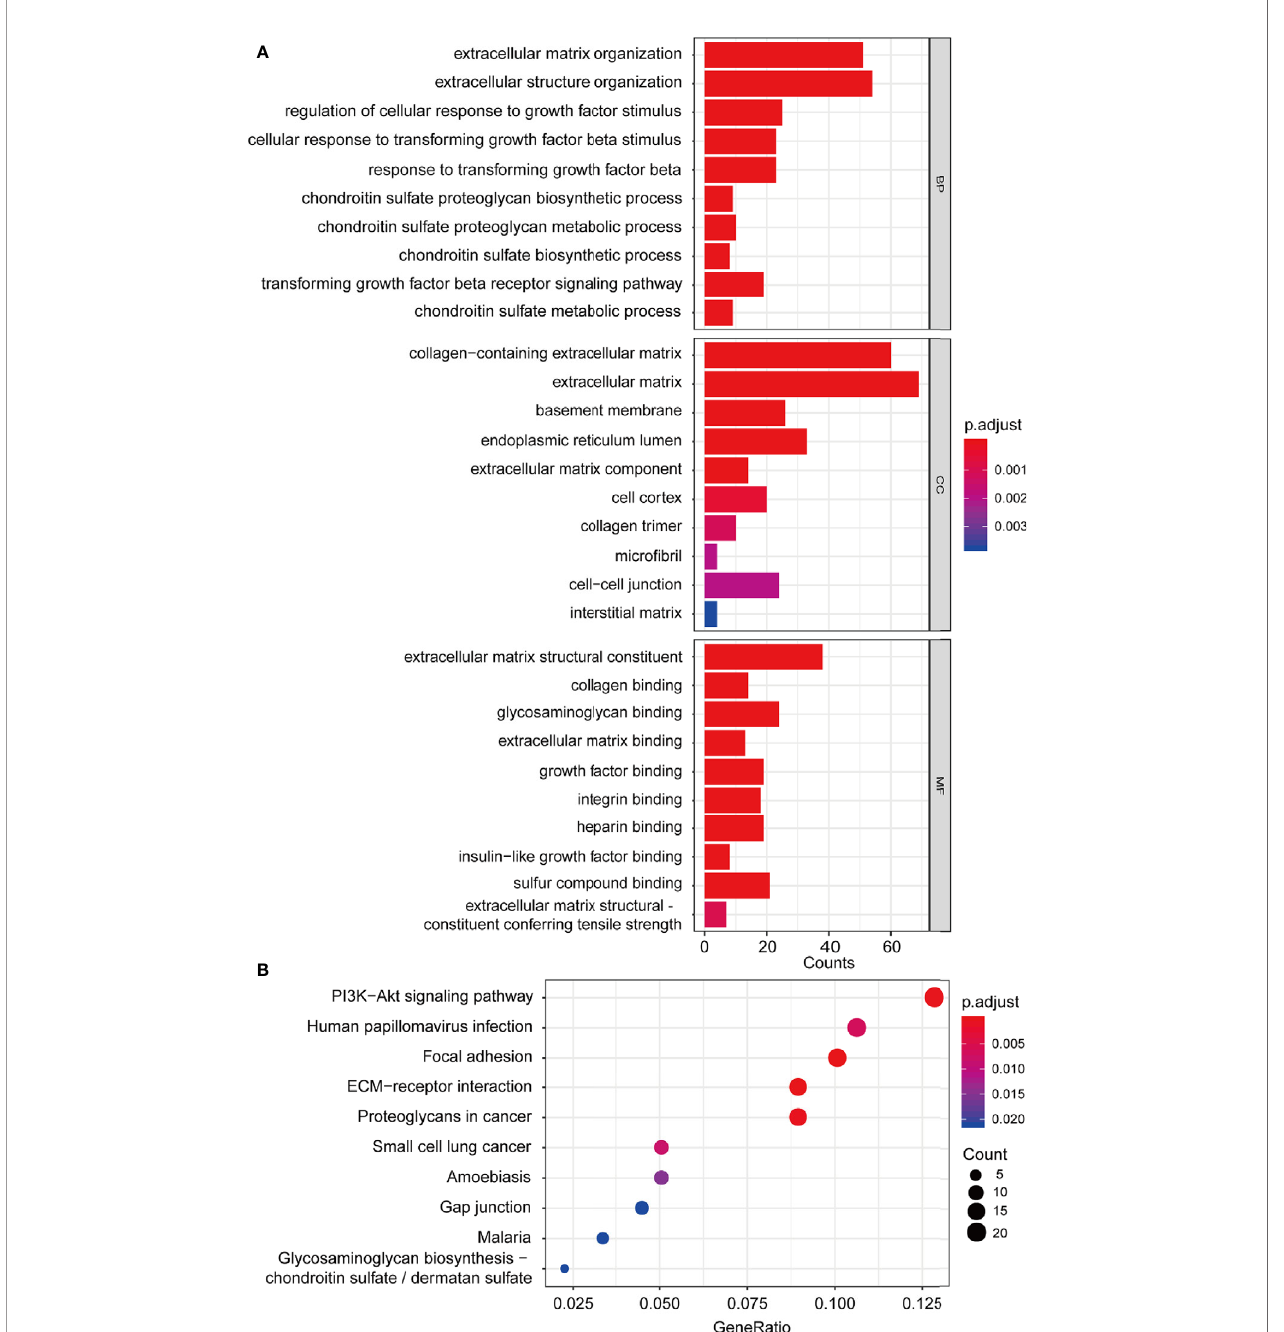
FIGURE 5 | Functional enrichment analysis. (A) GO enrichment analysis including biological process, cellular component, molecular function analysis; (B) KEGG pathway enrichment analysis. GO, Gene Ontology; KEGG, Kyoto Encyclopedia of Genes and